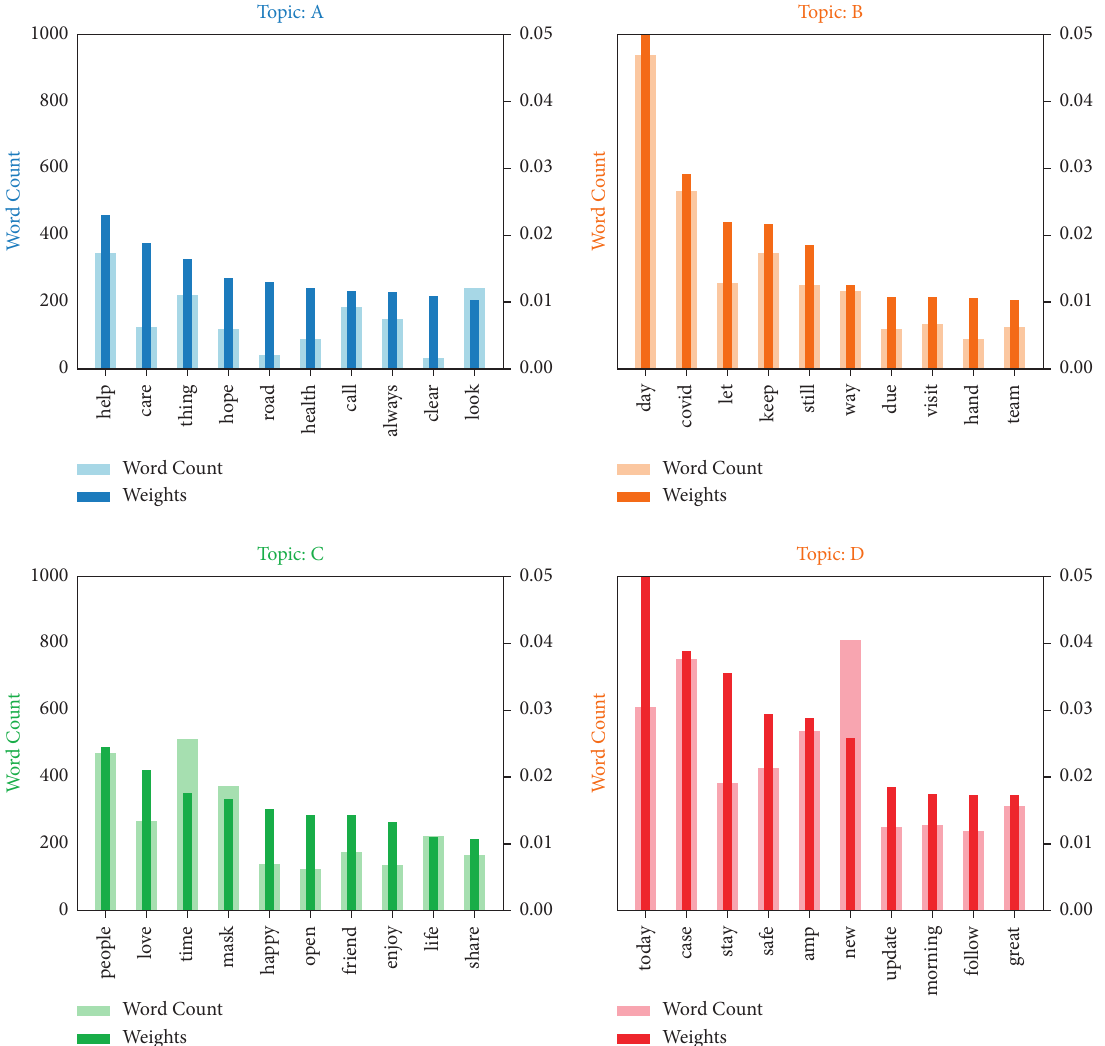
Figure 8: Extracted keywords and weight of their